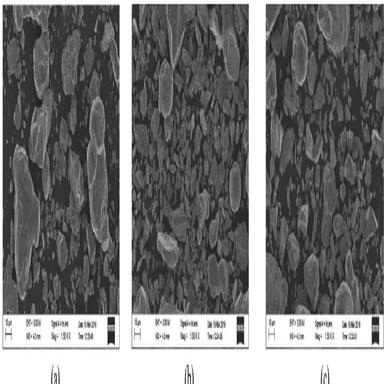
SEM powder morphology of (a) 3 h, (b) 4 h, (c) 5 h.